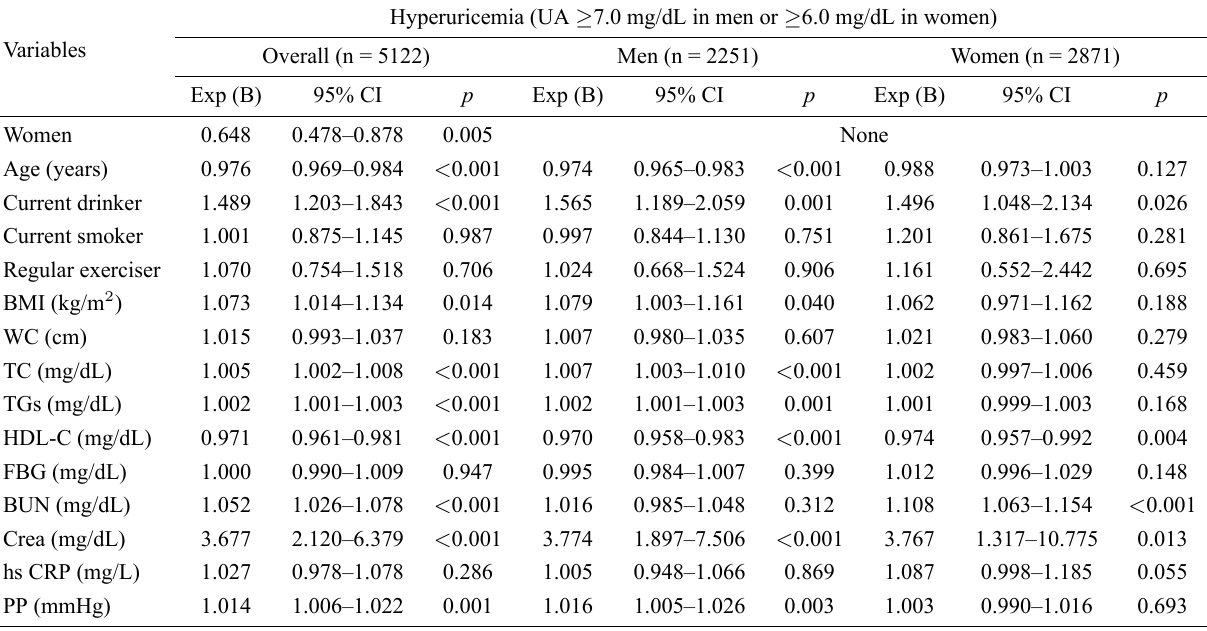
Table 4. Comparisons of hyperuricemia and pulse pressure.